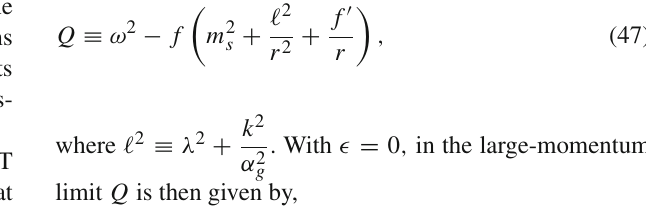
frequencies of the two lowest modes for scalar perturbations of a neutral black string for M = 1 ,α g = 1 ,(cid:14) = 0 ,α 2 m = − 0 . 16 ,γ = 1 . 5 ,λ = 1 with varying m s